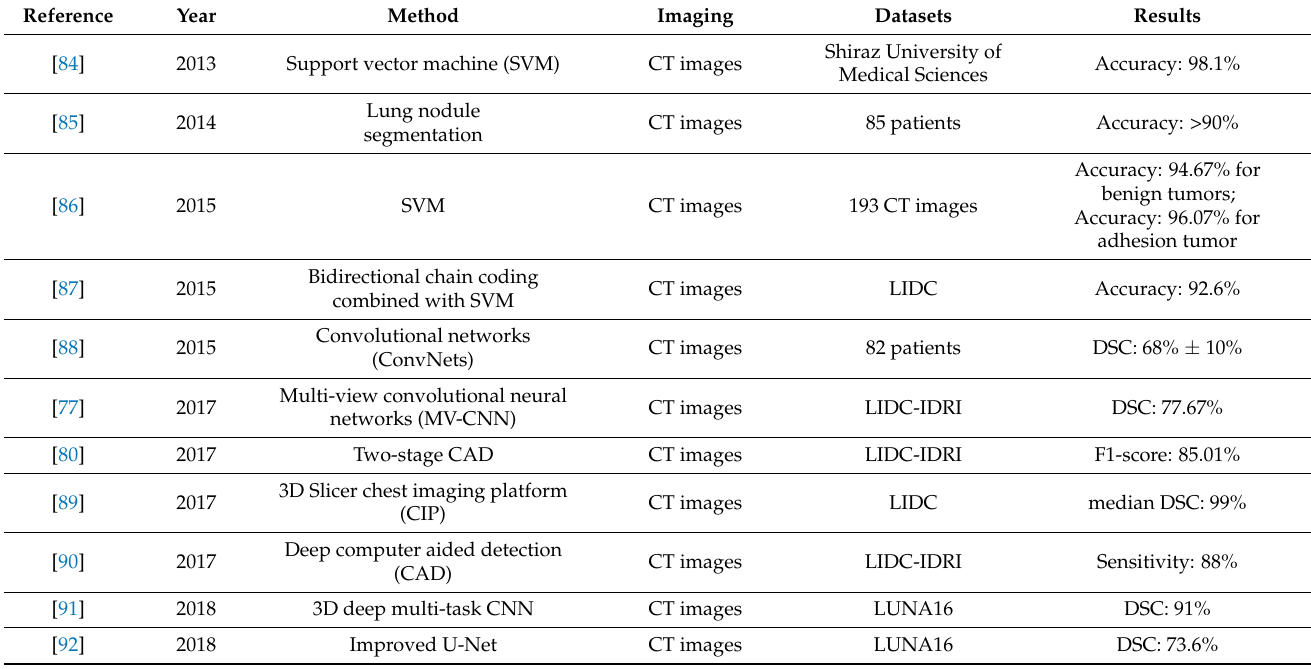
Table 2. Lung nodule segmentation